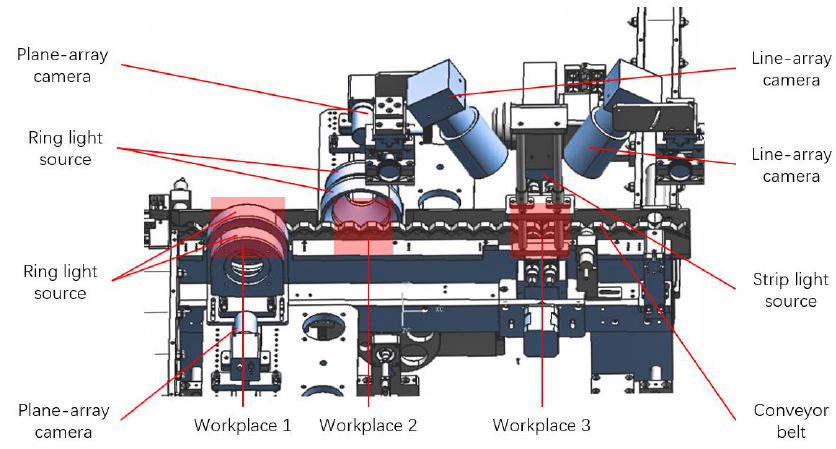
Figure 3. The surface inspection system.